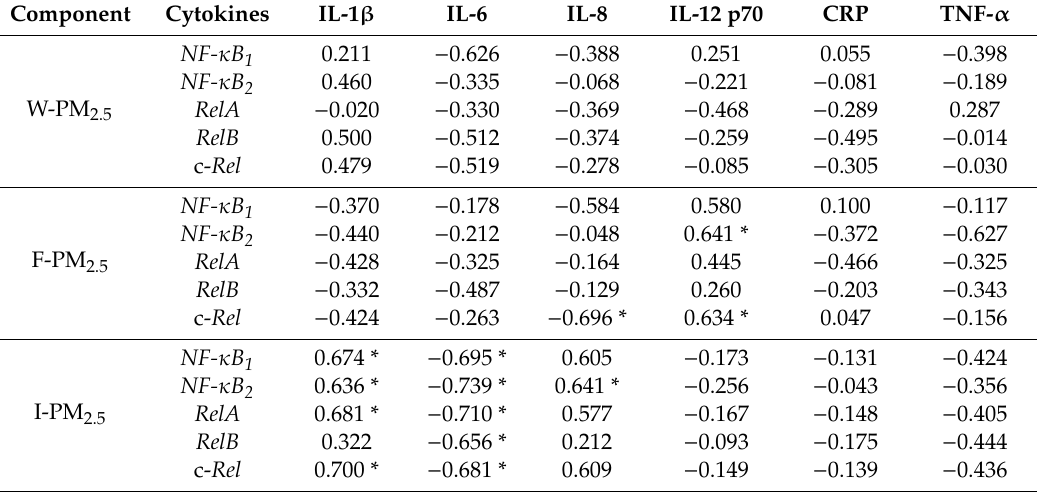
Table 3. Correlation between NF- κ B mRNA and inflammatory molecules of macrophage after PM 2.5